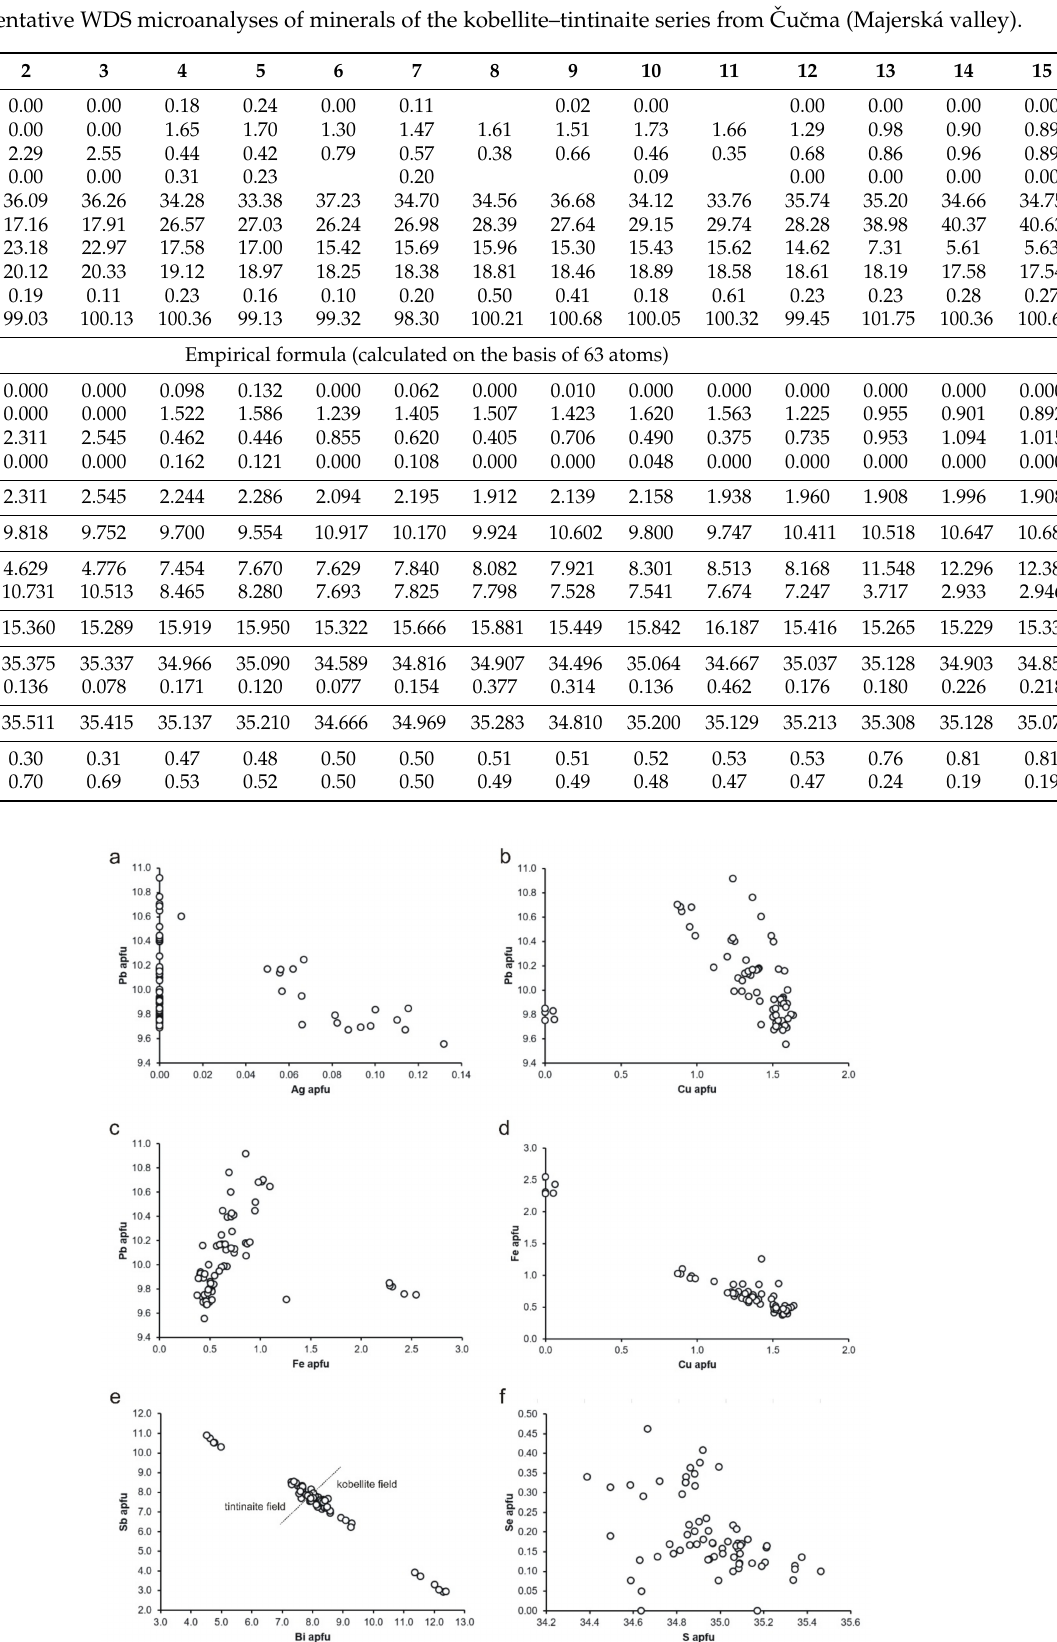
Figure 10. Interdependencies of elements in minerals of kobellite–tintinaite series: ( a ) Ag vs. Pb; ( b ) Cu vs. Pb; ( c ) Fe vs. Pb; ( d ) Cu vs. Fe; ( e ) Bi vs. Sb; ( f ) S vs.